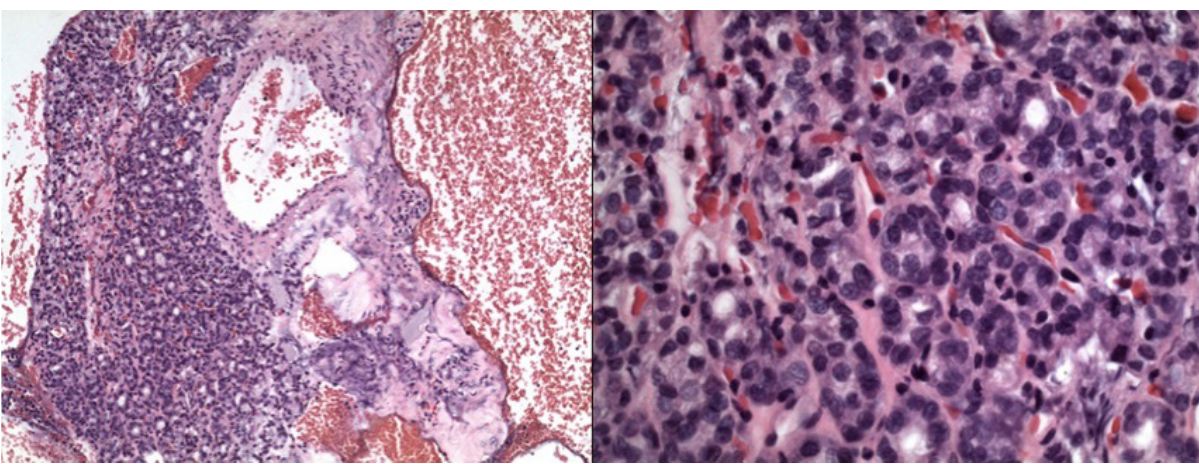
Fig. 1 A, B. FNAB cytoblock of the HTT case: Microphragment of a microfollicular homogeneous nodule with calcifications and FVPTC – like nuclei. Obj. magnif. 10× and 40×.